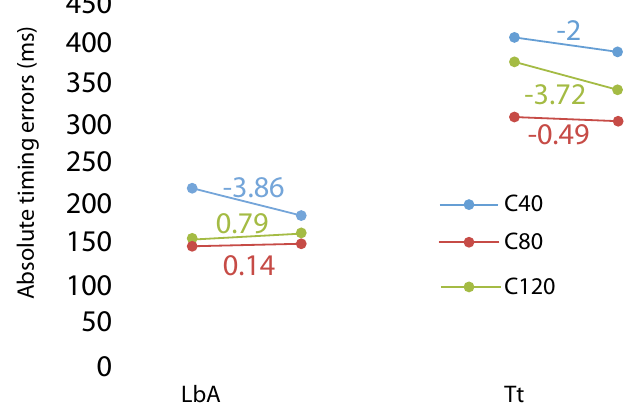
Figure 12 . Adaptation rates and regression slopes in relative and ab- solute timing measures in last block of acquisition (LbA) and transfer test